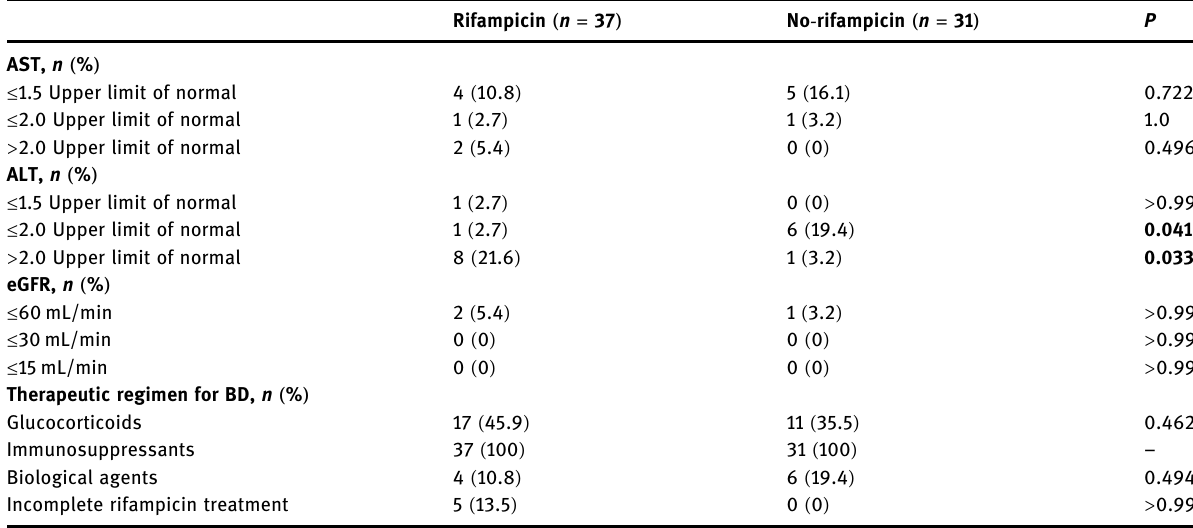
Table 4: Subgroup analysis for the presence or absence of rifampicin in the LTBI group Rifampicin ( n = 37 )